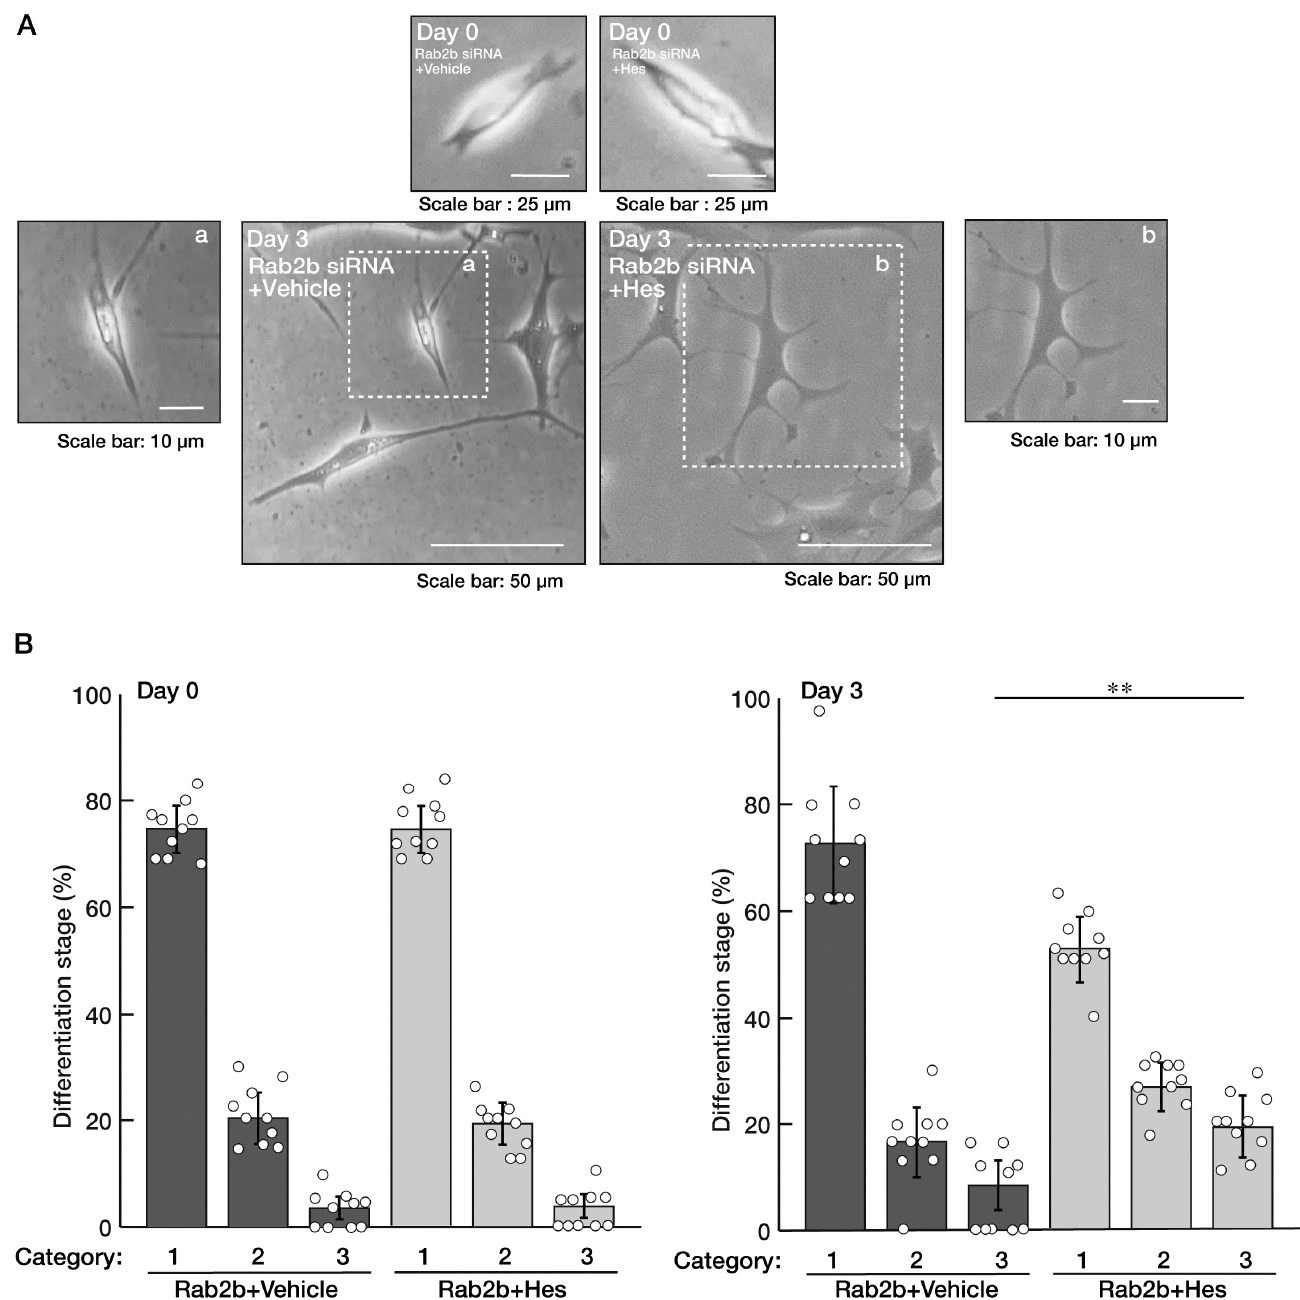
Figure 9. Hesperetin recovers decreased differentiated phenotypes induced by Rab2b knockdown in FBD-102b cells. ( A , B ) FBD-102b cells were transfected with Rab2b siRNAs and treated with a control vehicle or hesperetin (Hes, 1 μ M) for 0 or 3 days. Their cell morphologies were divided into 3 categories and statistically depicted as graphs (** p < 0.01; n = 10 fields). White circles show percentages in the respective independent experiments.